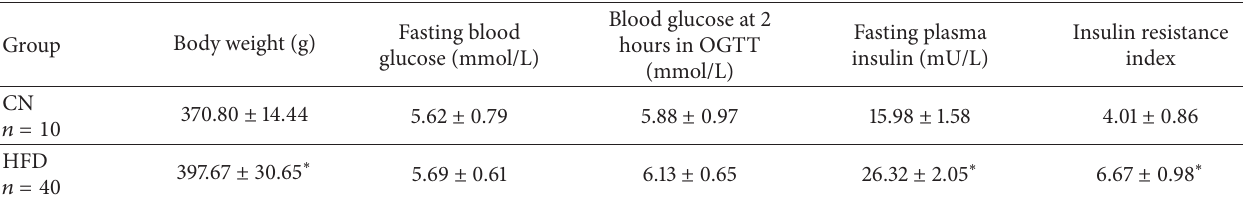
Table 1: Comparison of body weight, fasting blood glucose, blood glucose at 2 hours in OGTT, fasting plasma insulin, and insulin resistance index.